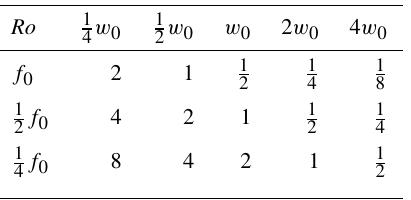
Table 1. Rossby number of each simulation, where f 0 = 0 . 105s − 1 and w 0 = 1 . 63m.